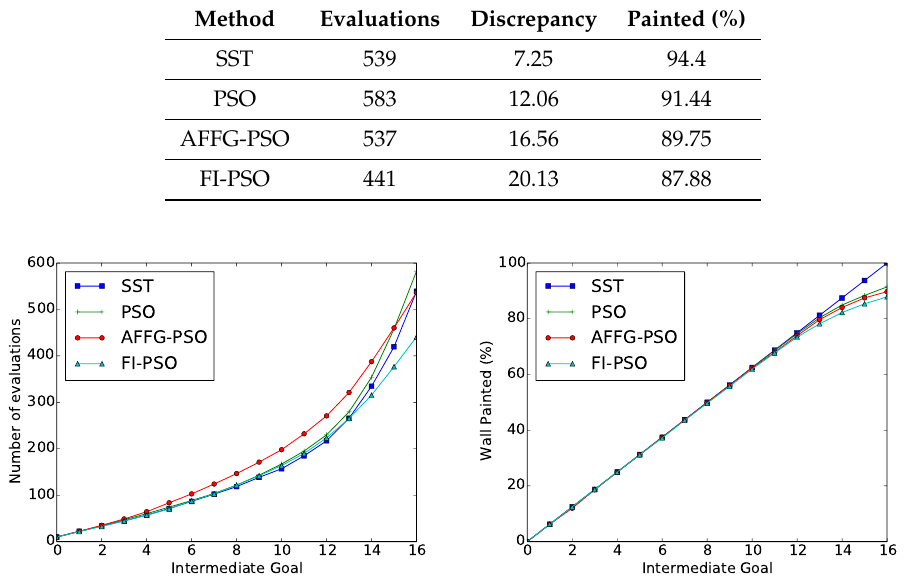
Figure 6. “Paint” Evolutionary Approximation results: Number of cumulative evaluations at each intermediate goal ( Left ). Comparison between the generalized trajectory and the executed ones ( Right ).